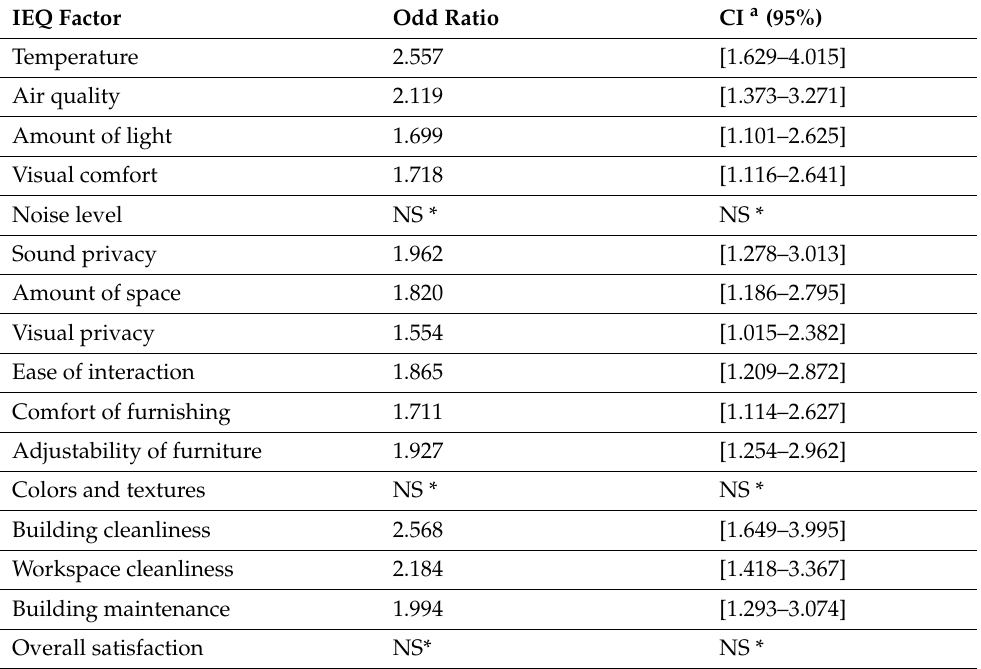
Table 4. Differences in satisfaction levels in terms of respondents’